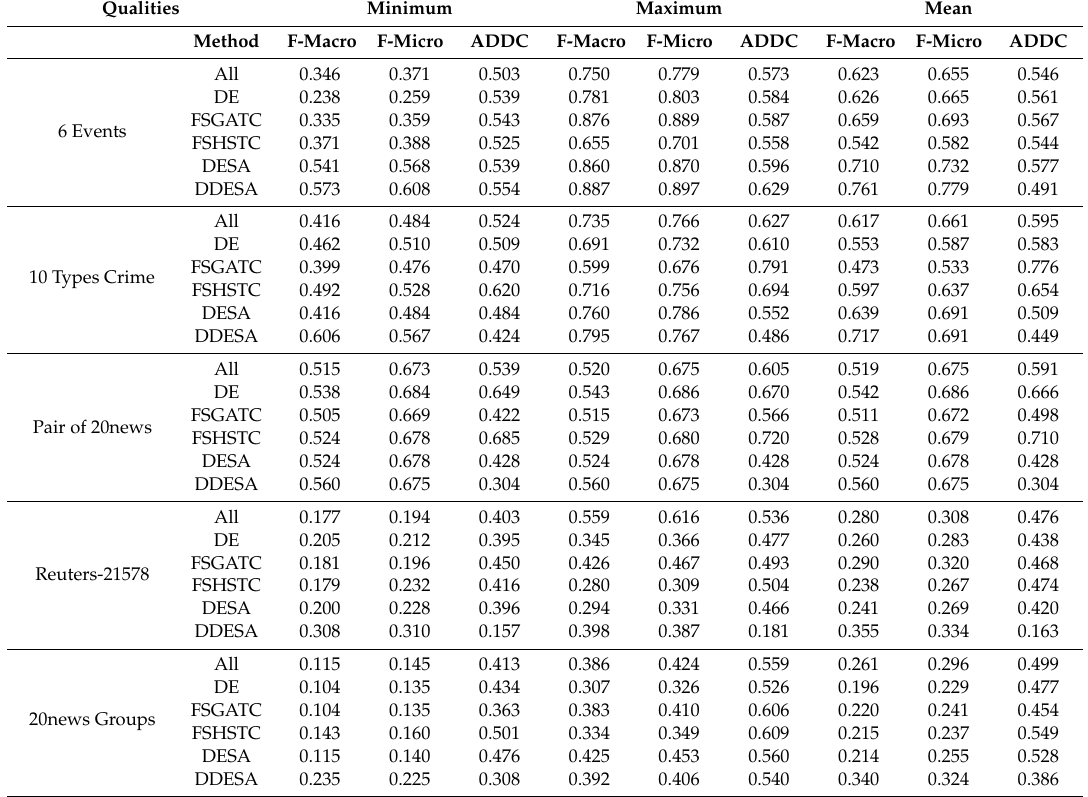
Table 4. Internal and external evaluation